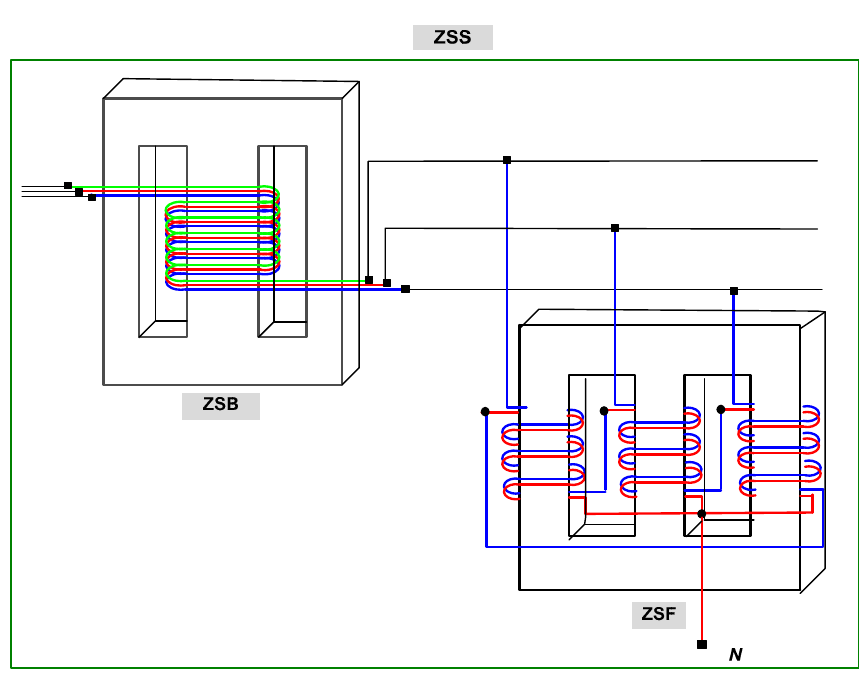
Figure 7. Electromagnetic structure of the zero-sequence electromagnetic suppressor (ZSS).